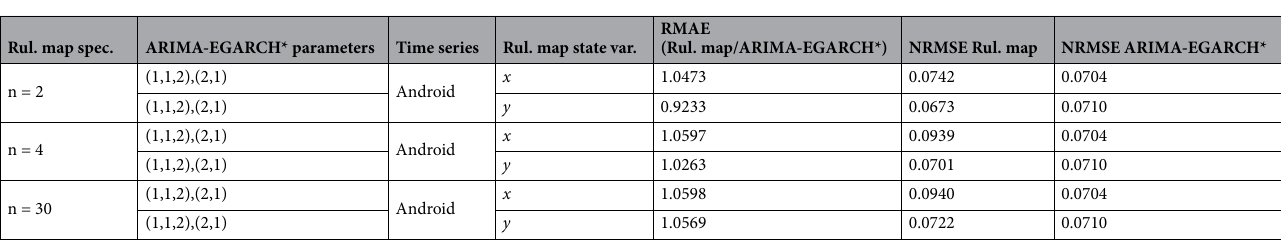
Figure 6. Modeling comparison: ( a ) Android time series variable x (blue), versus Rulkov state variable ( b ) Android time series variable y (blue), versus Rulkov state variable x (blue), vs. ARIMA-EGARCH* state variable y (red). state variable ˆ